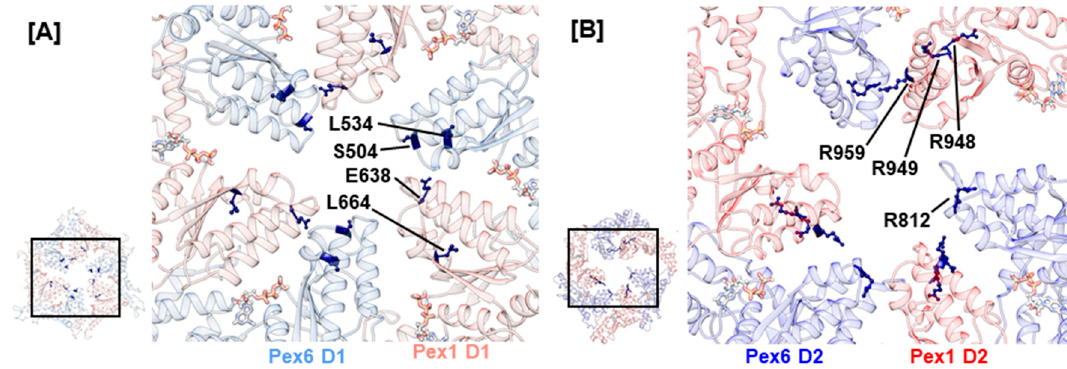
Figure 4. Structural mapping of mutations in pore loops 1 in the D1 ring ( A ) and pore loop 2 in the D2 ring ( B ). Amino acids concerned by mutations are presented as sticks and colored dark blue. Insets show the D1 and D2 ring as a top view with selection of the enlarged area. ATP is visualized as sticks.